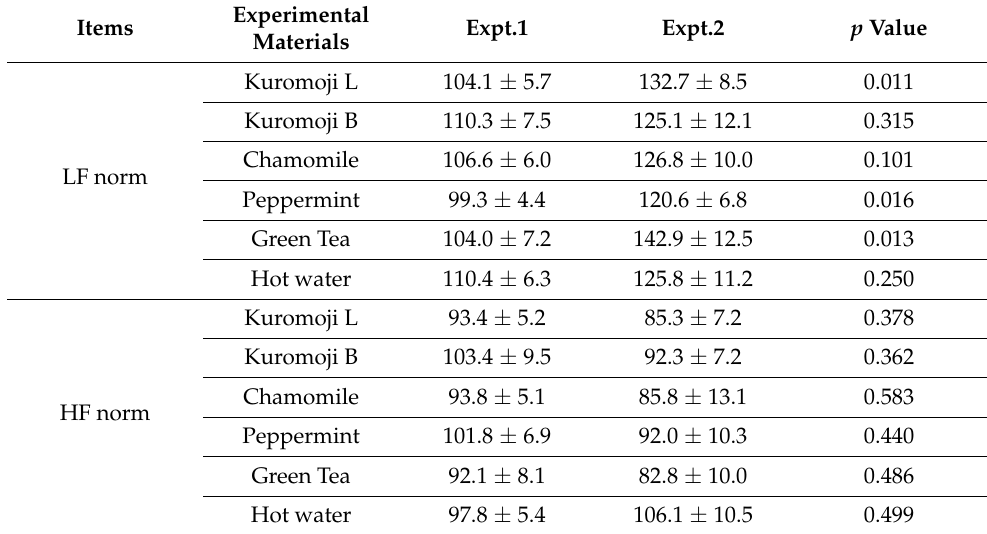
Table 2. Relative values of normalized low and high frequencies.